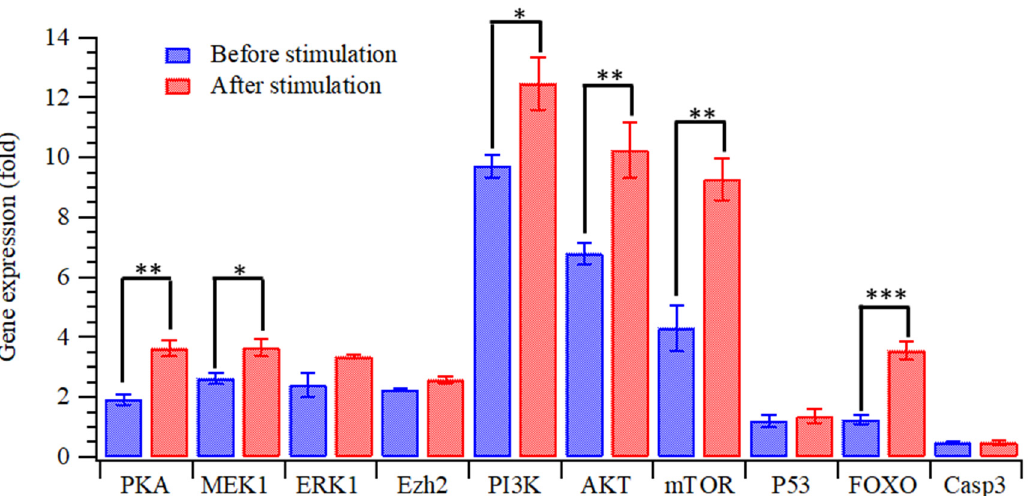
Figure 6. Relative gene expression of proteins of insulin-activated HEK-293T cells with MPIPs/RNPs before and after glucose stimulation. Many genes responsible for cellular proliferation are concomitantly upregulated with insulin. All experiments were carried out in triplicate, and data are expressed as means ± standard deviation; *: p < 0.05, **: p < 0.005, and ***: p < 0.0005.